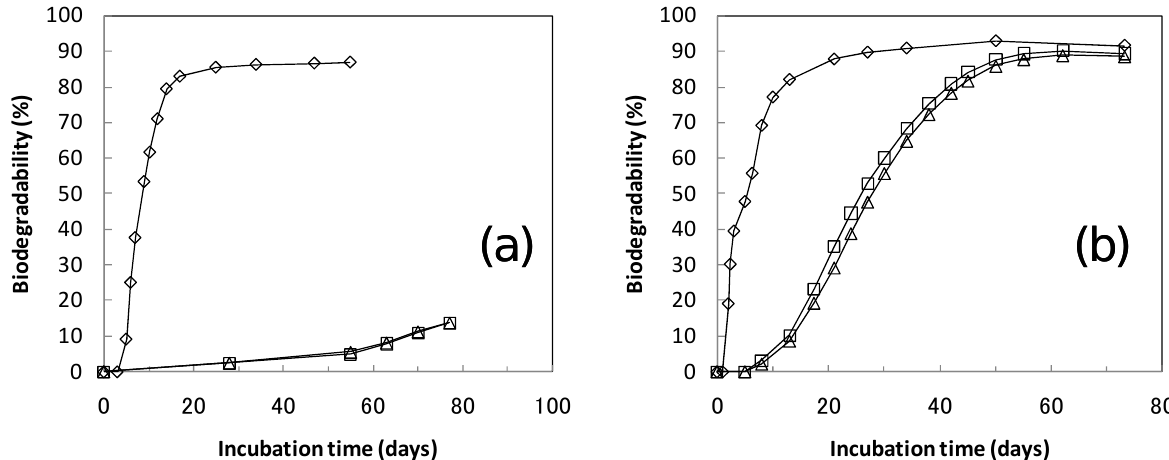
Figure 5. Provisional biodegradability in PLA anaerobic biodegradation